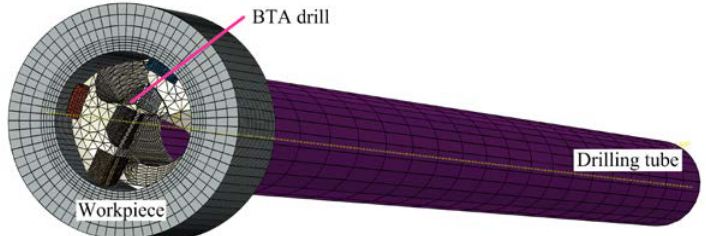
Figure 7. Mesh division of the extrusion model of guide pad and hole wall of BTA deep hole drill.